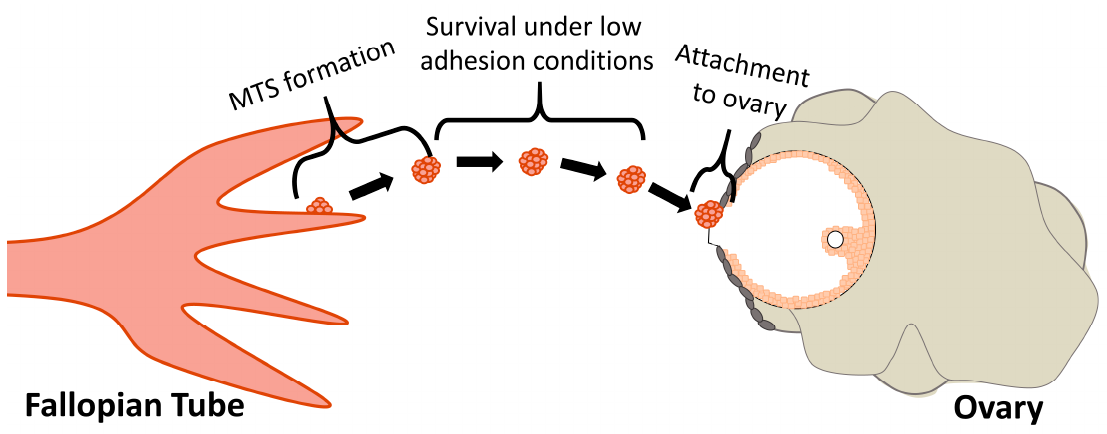
Figure 8. Schematic outlining the three steps necessary for MTS to mediate metastasis from the fallopian tube to the ovary. (1) MTS formation. After genetic alterations (e.g., loss of PTEN ), the FTE overgrow and collectively detach from the fimbria. (2) Survival under low adhesion conditions. Cell-to-cell contacts in the MTS enhance cell survival while the cells are traversing from the fallopian tube to the ovary. (3) Attachment to the ovary. MTS preferentially attach at the site of ovulation due to the loss of OSE. However, if the MTS attach elsewhere, the MTS can displace OSE cells to invade the ovary.